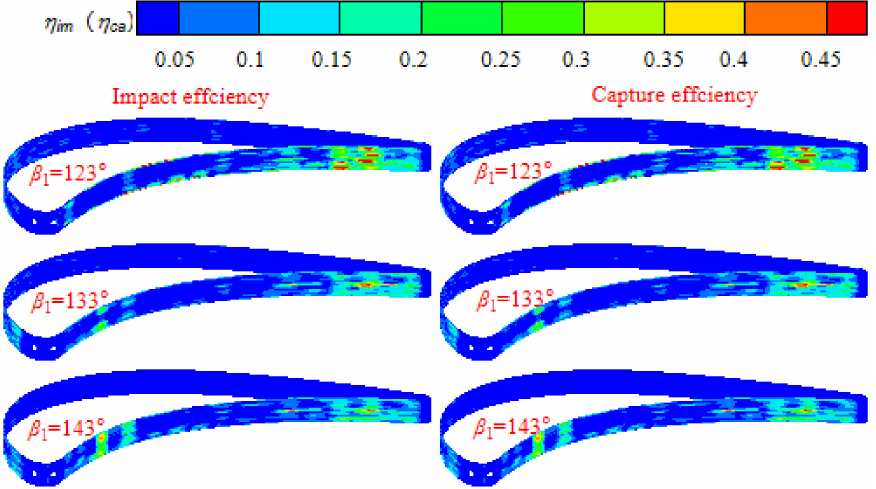
Figure 7. Distribution of impact efficiency and capture efficiency ( M = 0.68, d p = 1 µ